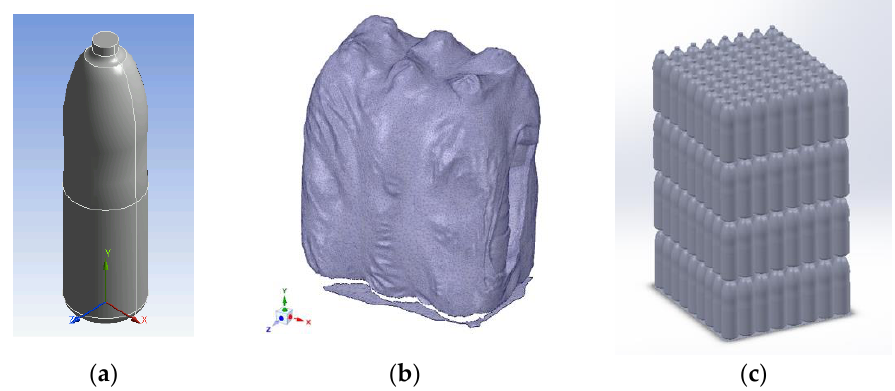
Figure 16. Discretization by a multilevel approach: ( a ) single bottle; ( b ) bottles in bundles; ( c ) pallet.